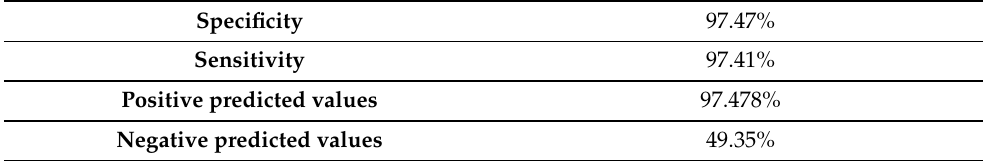
Table 7. Validation outcomes